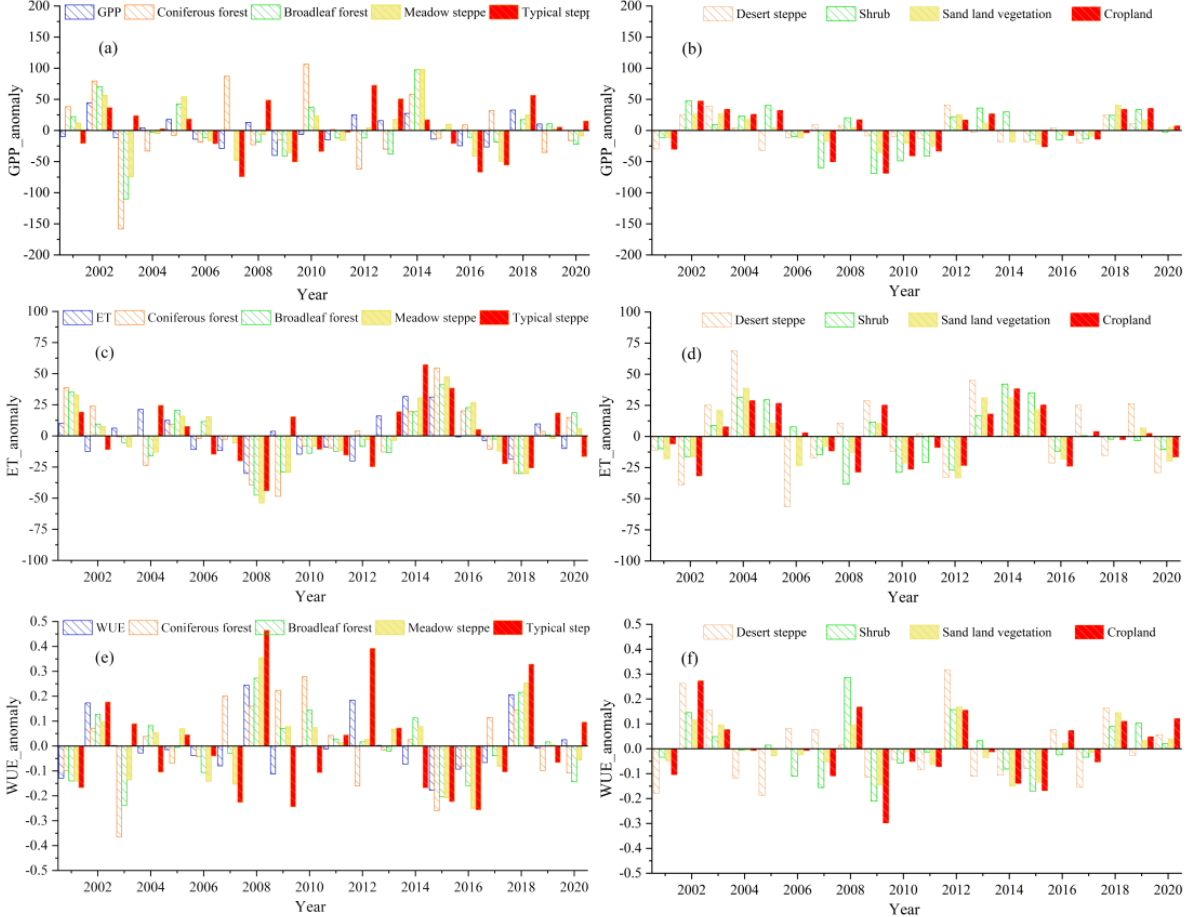
Figure 6. The anomaly of GPP, ET, and WUE for different vegetation types from 2001 to 2020; ( a , b ) GPP, ( c , d ) ET, and ( e , f ) WUE.